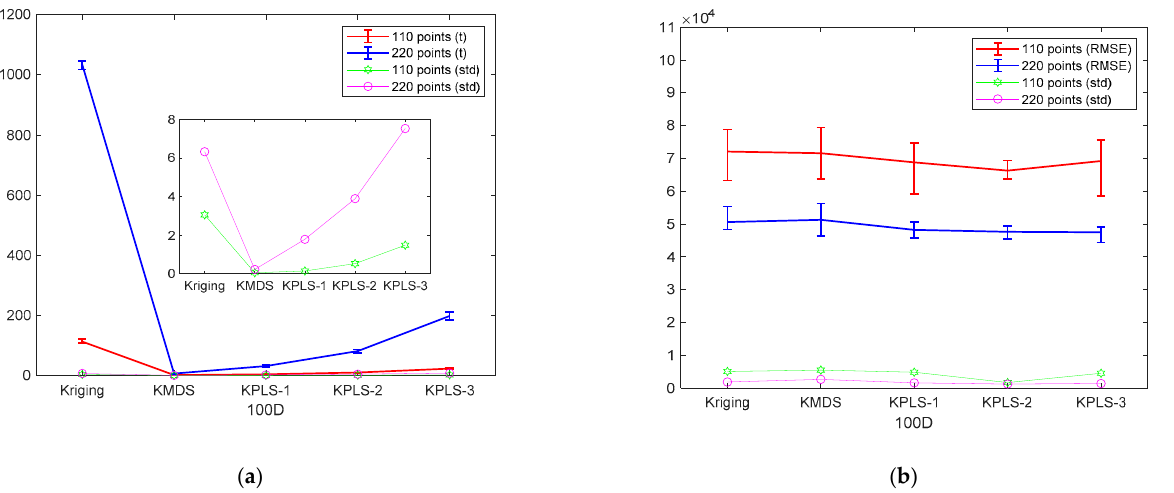
Figure 9. ( a ) Modeling time and its standard deviation for the 100D Rothyp function. ( b ) RMSE and its standard deviation for the 100D Rothyp